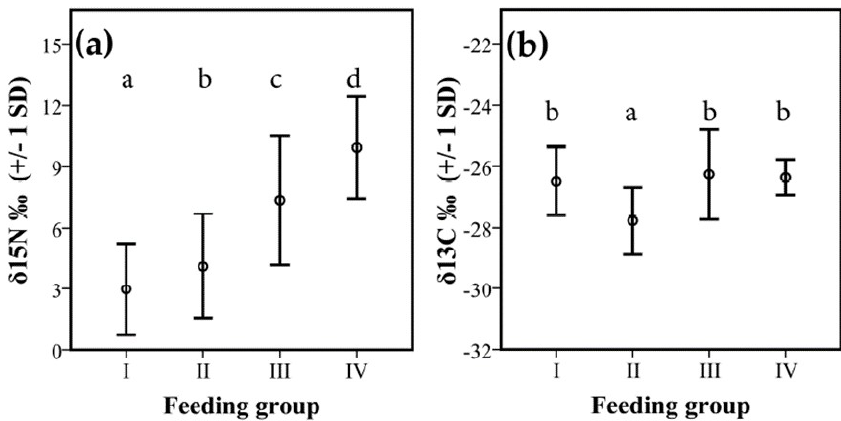
Figure 5. Difference in isotope signatures between feeding groups. Shown are mean values +/− 1 SD for (a) δ 15 N‰ and (b) δ 13 C‰ between the four feeding groups: I: dead wood-feeders; II: dead wood, wood, leaf, plant-litter feeders; III: humus feeders; and IV: true soil feeders. Different letters indicate significant differences in litter samples ( p < 0.05, Tables A3 and A4).